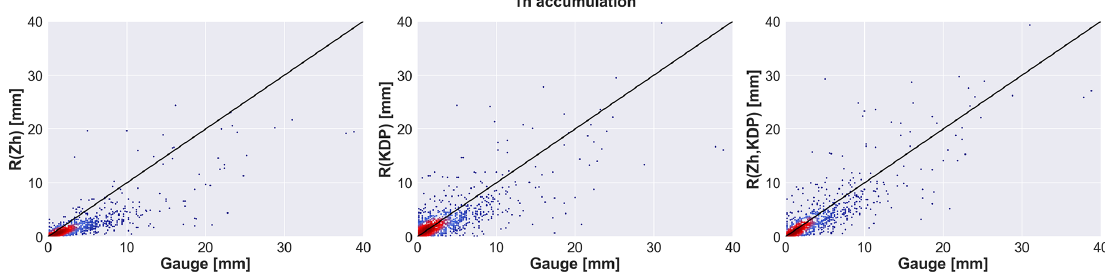
Figure 6. The 1h accumulations for Italy, 2012–2016. The corresponding verification measures are presented in Table 4. The number of radar–gauge data pairs with 42 gauges and accumulations > 0 . 1mm is 1233. Z H is not corrected for attenuation.